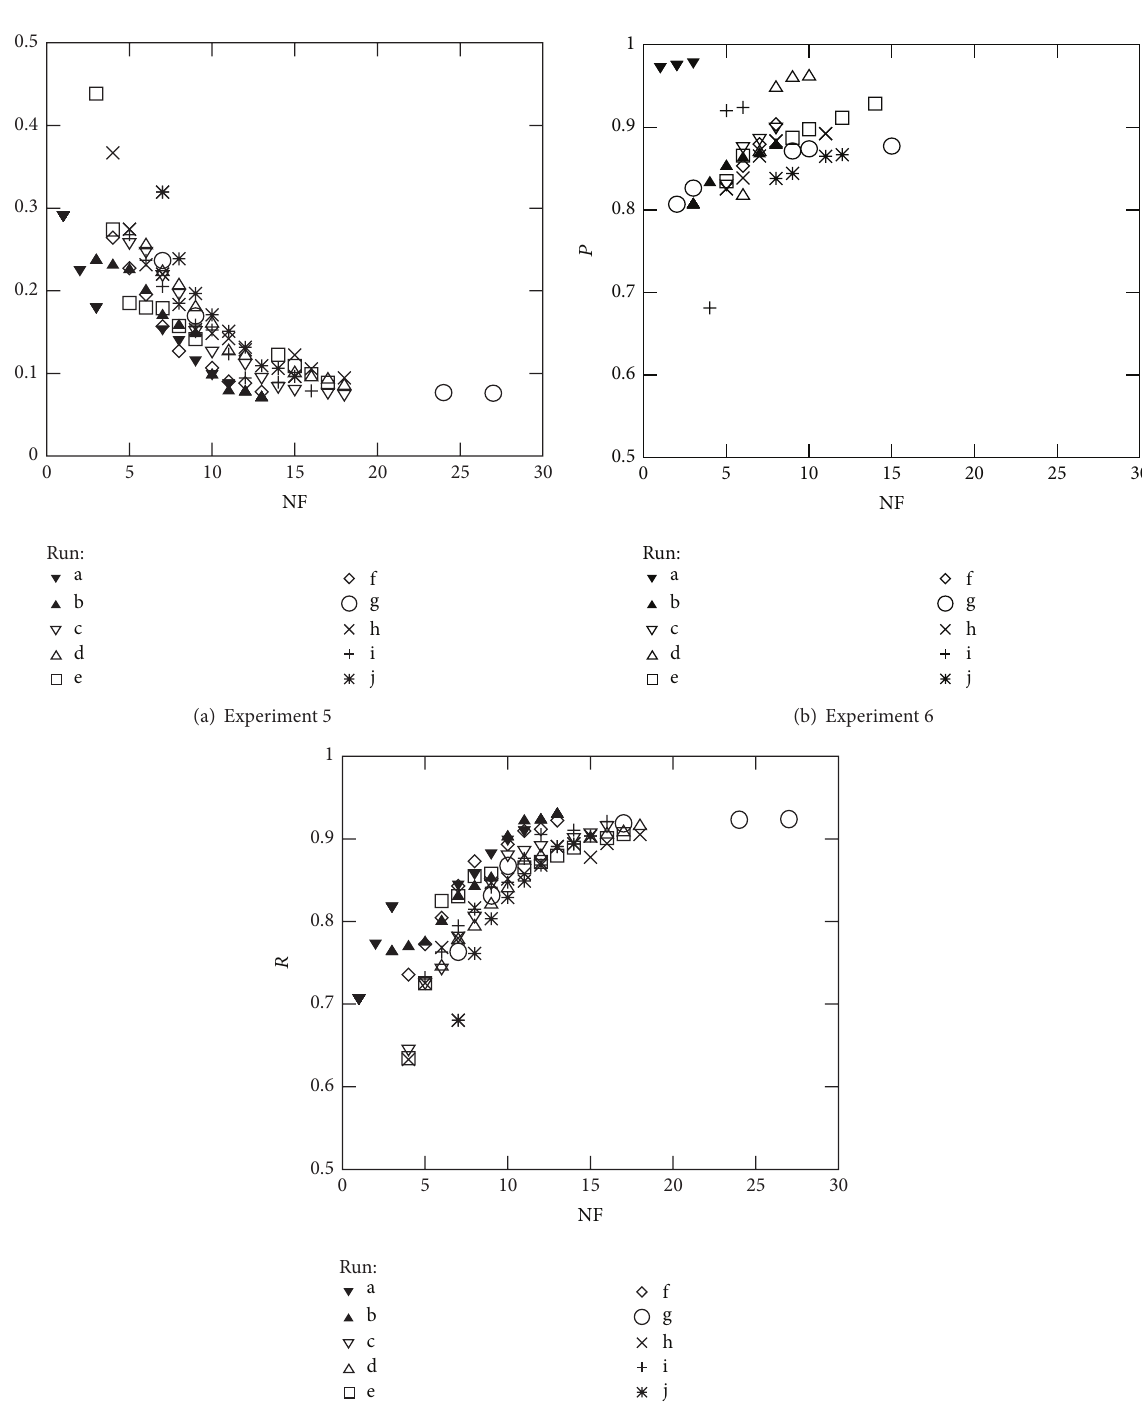
Figure 6: Optimal Pareto fronts for Diane 2005 data (10